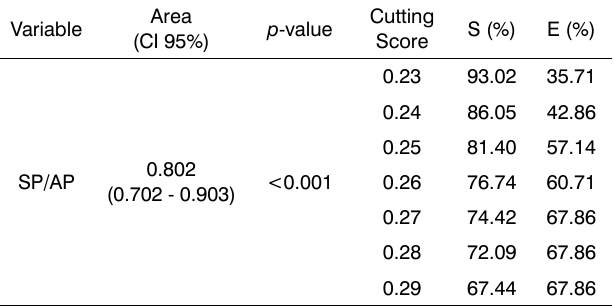
Table 5. Area under the ROC curve, cutting scores and res- pective sensitivity and specificity values for the SP/AP ratio for GC and GDM.